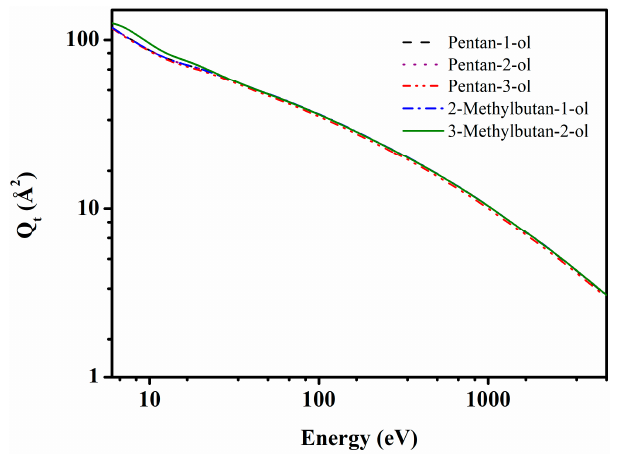
Figure 8. Total cross-section of pentanol isomers (present): dashed (black) line represents penta-1-ol, dotted (purple) is for pentan-2-ol, dash-dot-dot (red) line is for pentan-3-ol, dash-dot (blue) line represents 2-methylbutan-1-ol and solid (olive) line represents 3-methylbutan-2-ol results.